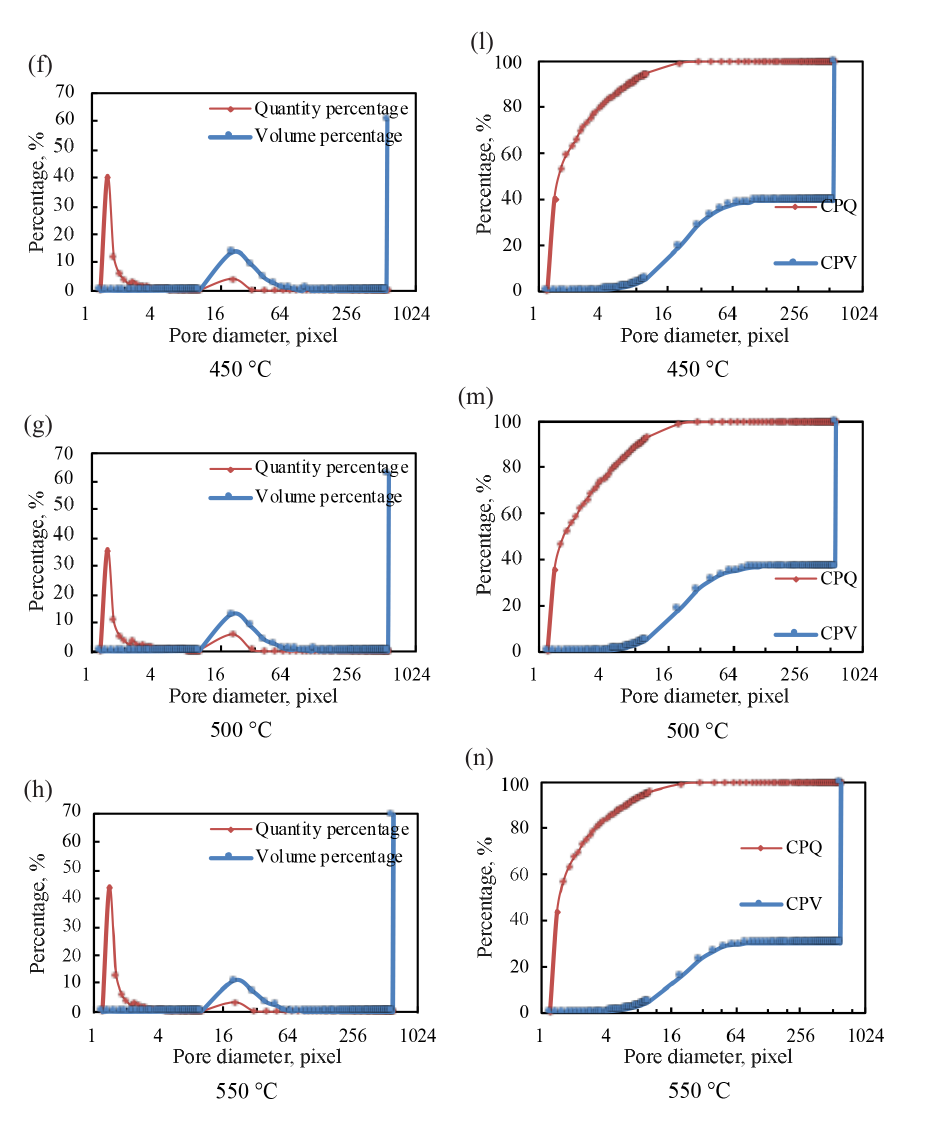
Fig. 6. Pore size and volume distributions of oil shale samples at different temperatures: (a) original sample at 25 °C; (b) original sample at 25 °C; (c)–(h) samples with the number and volume percentages of pores smaller than a specific size; (i)–(n) samples with the cumulative percentage of quantity (CPQ) and volume (CPV) of pores smaller than a